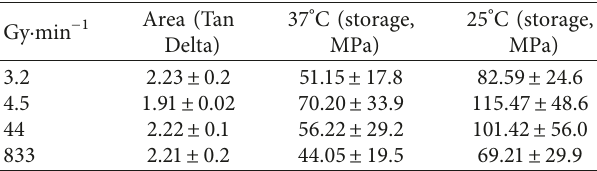
Table 3: DMA results indicating significant changes between factors ( n � 3, p < 0 . 05, error displayed in standard